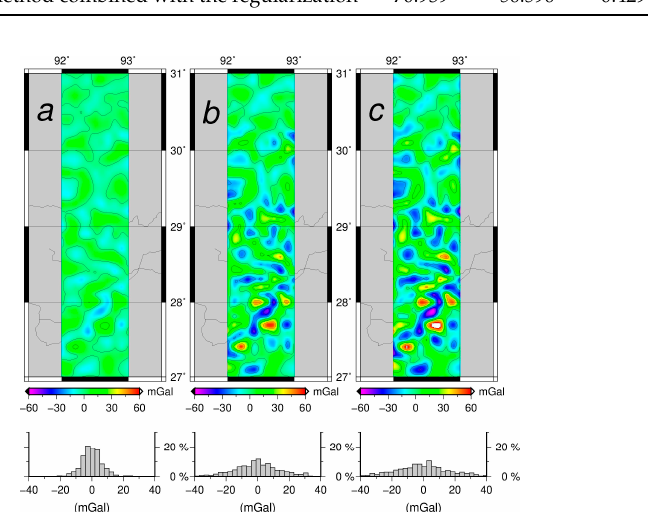
Figure 5. Distributions and histograms of differences between the downward continued values and the original values in the Tibetan Plateau ( a ) 11.5 km to 5.5 km; ( b ) 5.5 km to 0 km; ( c ) 11.5 to 0 km.